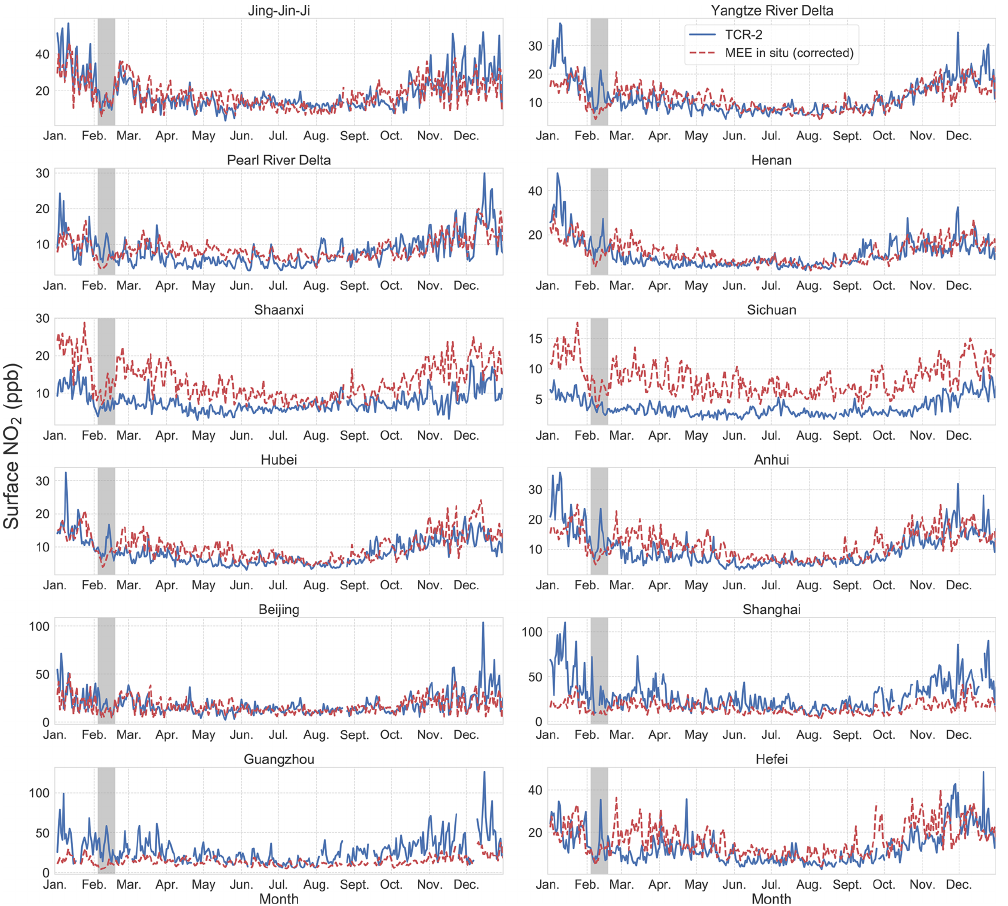
Figure 7. Time series of daily mean surface NO 2 concentrations in 2019 for the three Chinese metropolitan regions, selected provinces, and major cities shown in Fig. 6. The corresponding TCR-2 NO 2 data sampled at MEE sites are shown in blue, whereas the MEE ground-based NO 2 observations are indicated by the dashed red line. The shaded areas represent the 14d period after the Chinese New